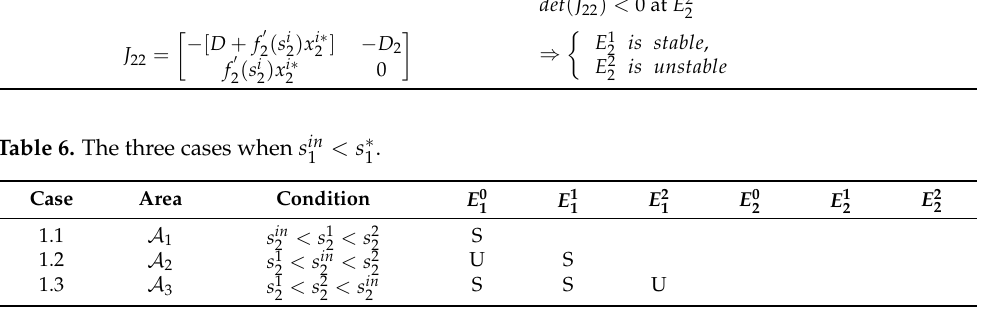
Table 7. The six cases when s in